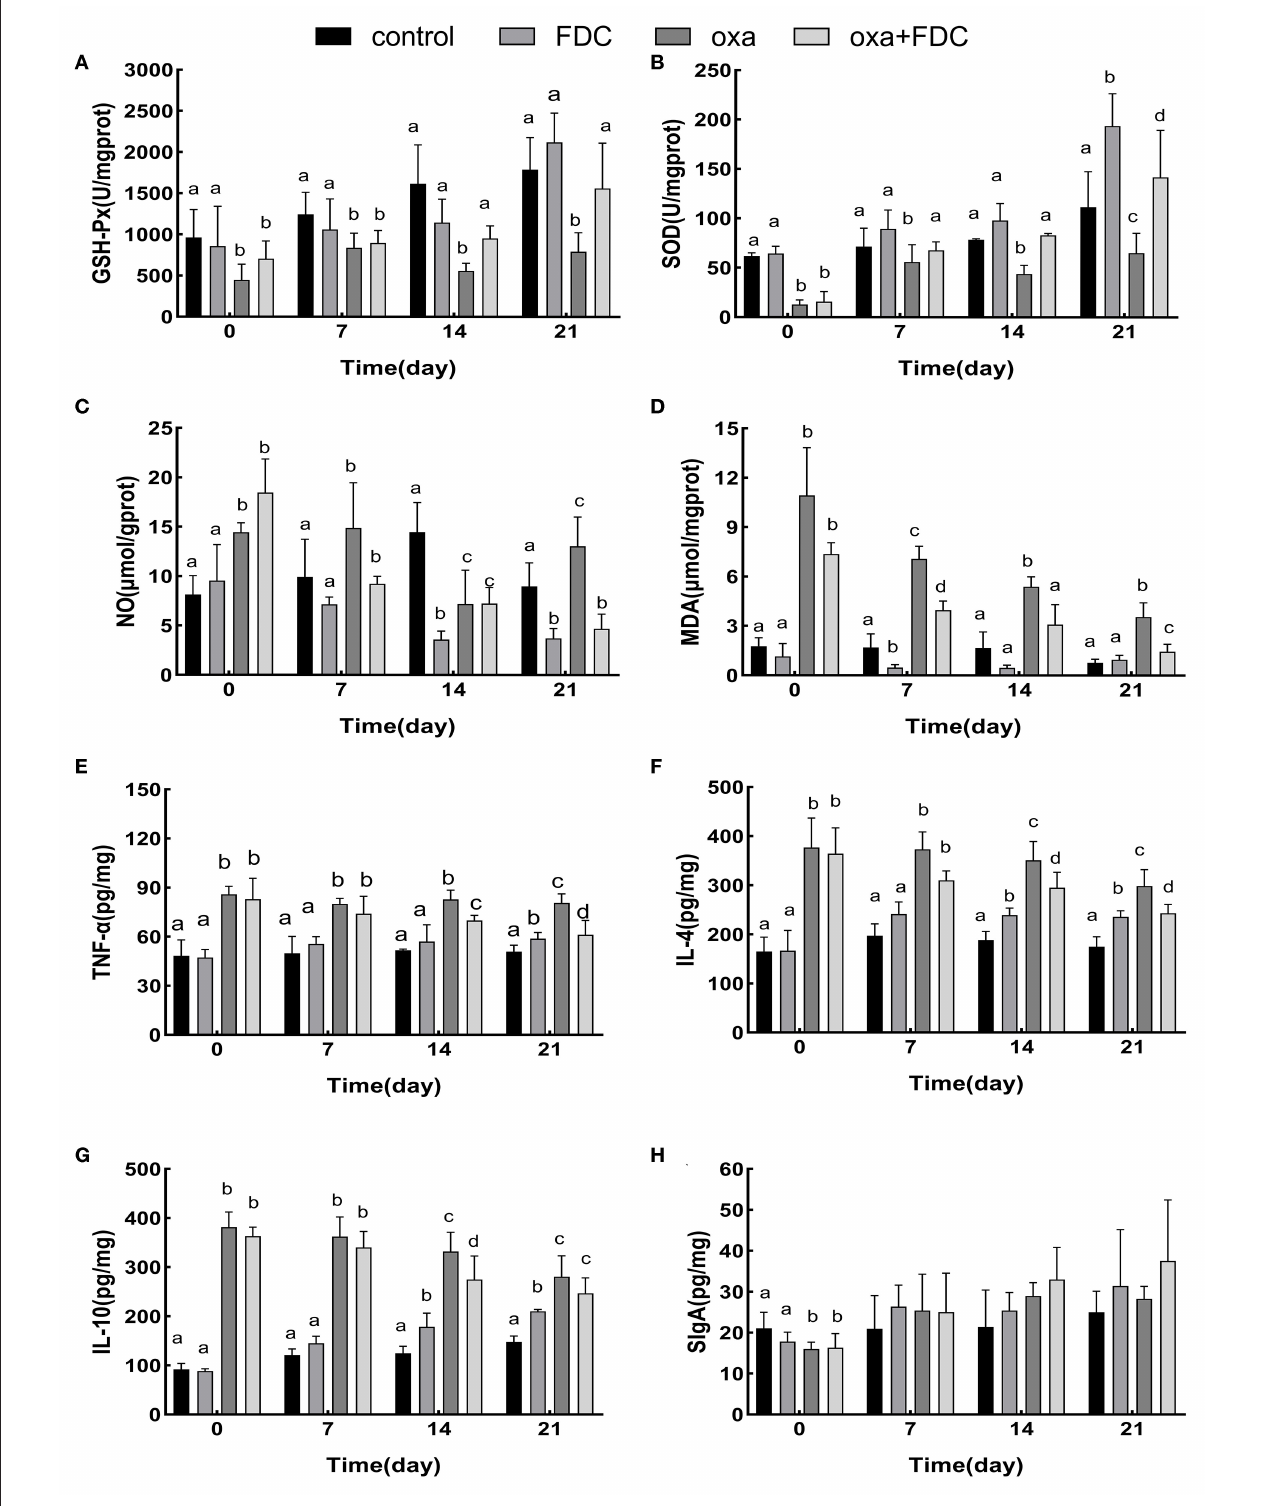
FIGURE 3 | Comparative analysis of the intestinal immunity index (A–H). Data are expressed as the mean ± SD. The same letter is not significantly different from each other ( P < 0.05) on the same day.